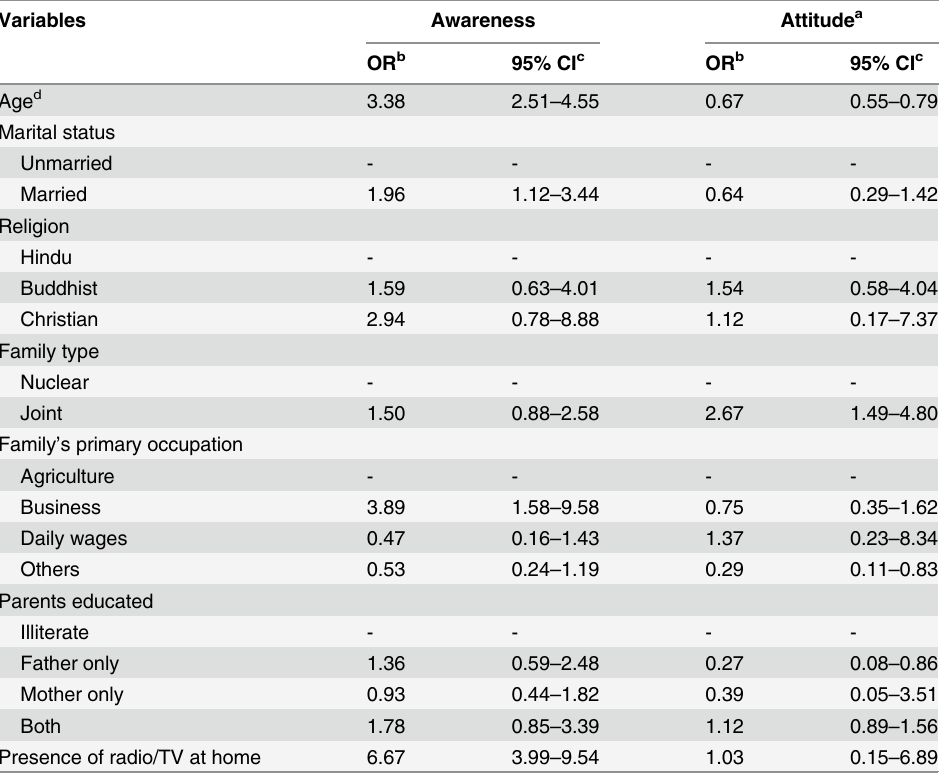
Table 4. Association of socio-demographic characteristics with awareness and attitude related to sex